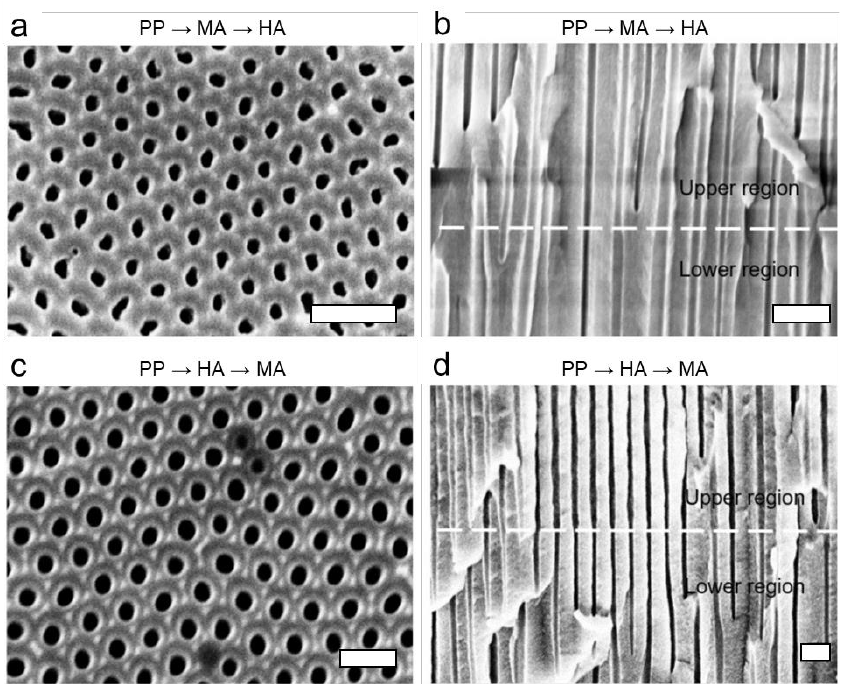
Figure 4. SEM images of the nanoporous alumina layer formed on the pre-patterned (PP, via MA) aluminum substrate, as a result of the stepwise anodizing process with the modulated anodizing voltage. ( a , b ) Top and cross-sectional views of the nanoporous alumina layer formed by MA (40 V, 30 min) followed by HA (100 V, 0.5 min). ( c , d ) Top and cross-sectional views of the nanoporous alumina layer formed by HA (100 V, 0.5 min) followed by MA (40 V, 30 min). The scale bar in each image represents 200 nm.